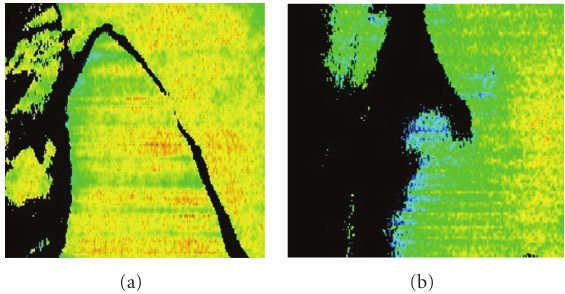
Figure 6: (a) Case that flow became bad when MC flap is collected. The MC flap on the other side was collected without the MC flap separating because the blood flow was bad. (b) State of flow on the second day of after the operation of the flap. The blood flow worsened and the edge of the flap got the sphacelation. The necrotic part of the flap is displayed blacking